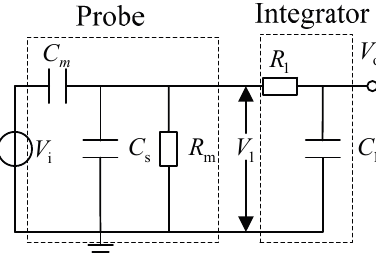
Figure 2. Equivalent circuit of the traditional probe and passive